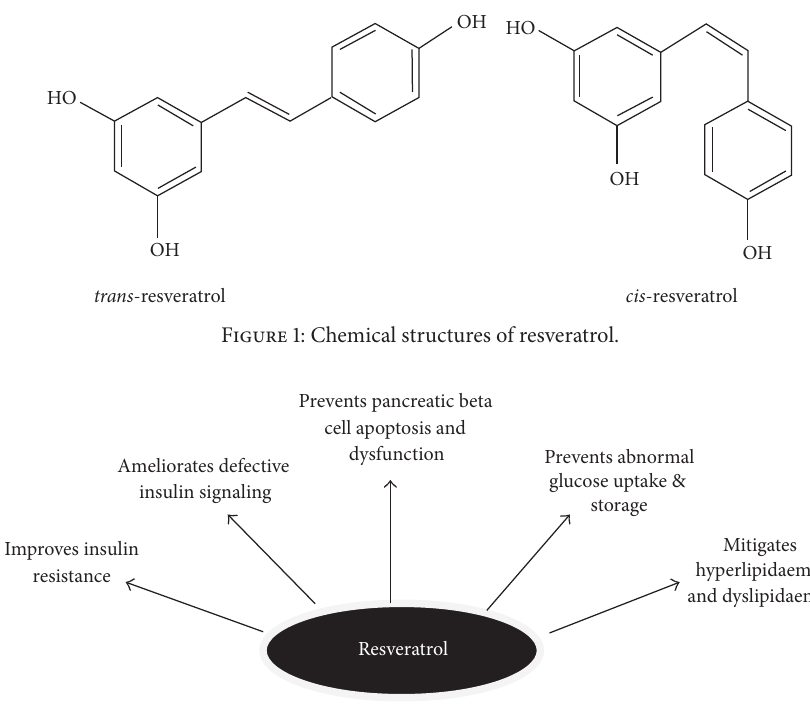
Figure 2: Protective effects of resveratrol in diabetes mellitus , adapted from [59, 64, 71, 120–122].